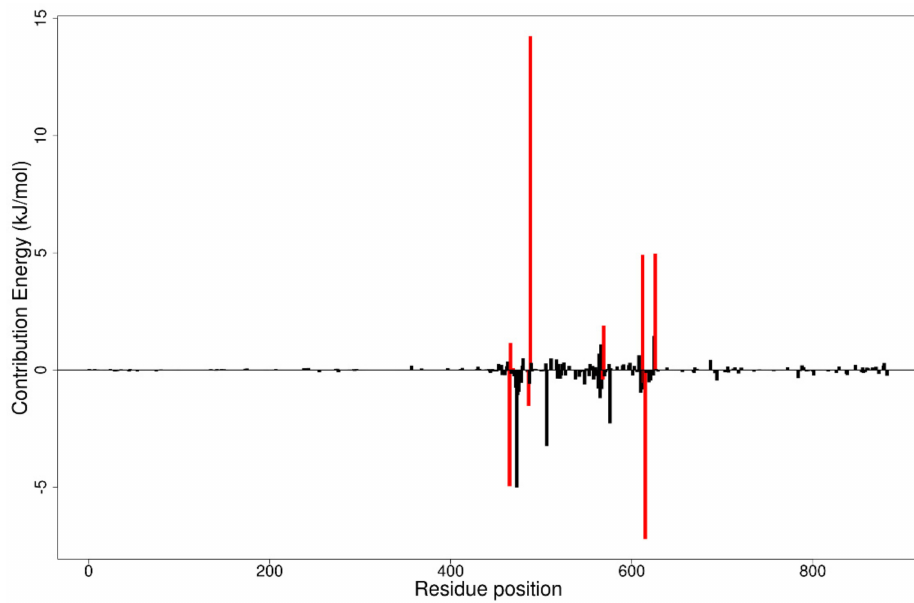
Figure 8. Molecular mechanics Poisson–Boltzmann surface area (MM/PBSA) plot of binding free energy contribution per residue of the Ld CRK12-NANPDB1406